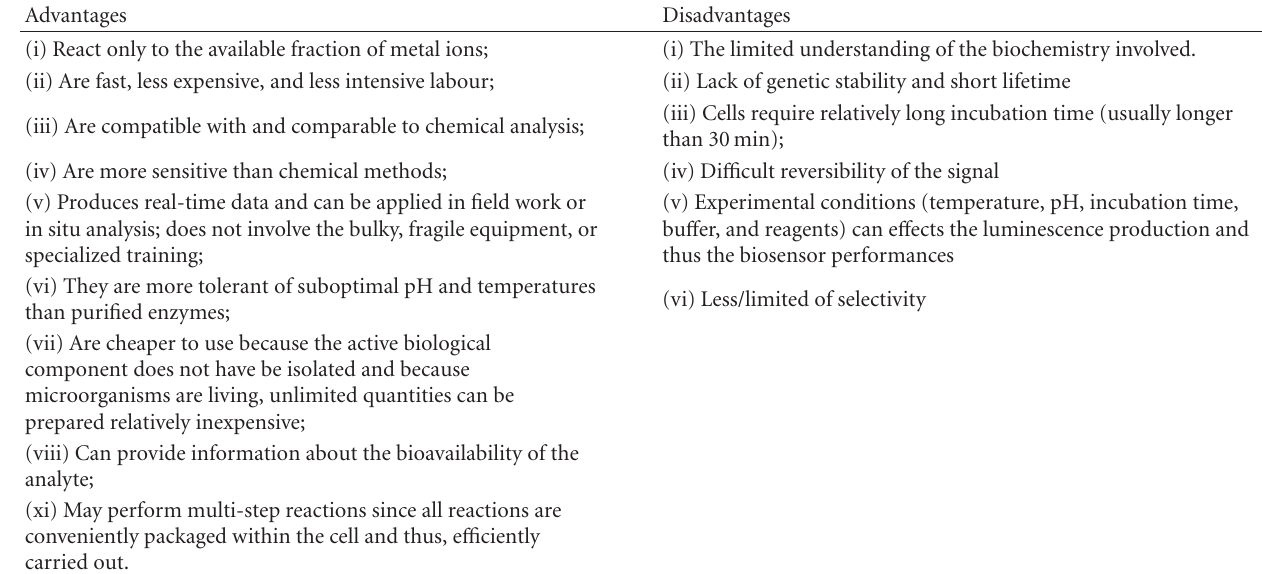
Table 6: Advantages and disadvantages of whole cell based